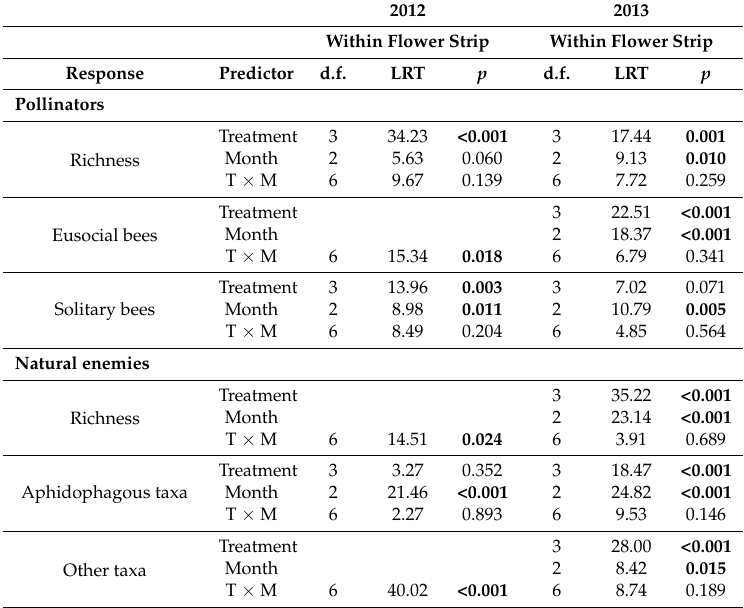
Table 1. Summary of minimum adequate models selected by inference on likelihood ratio tests. Effects of treatment (factor with four levels: control, concealed-nectar mix, mixed plots, and open-nectar mix), sampling month (factor with three levels: June, July and August), and the interaction between treatment (T) and month (M) on pollinator richness, pollinator abundance (eusocial bees and solitary bees; flower strips only), aphidophagous natural enemy abundance, other natural enemy abundance and natural enemy richness in orchard alleyways. Degrees of freedom (d.f.), test statistics (LRT) and p -values from likelihood ratio tests are shown. p -values of fixed effects included in final models are presented in bold ( p <